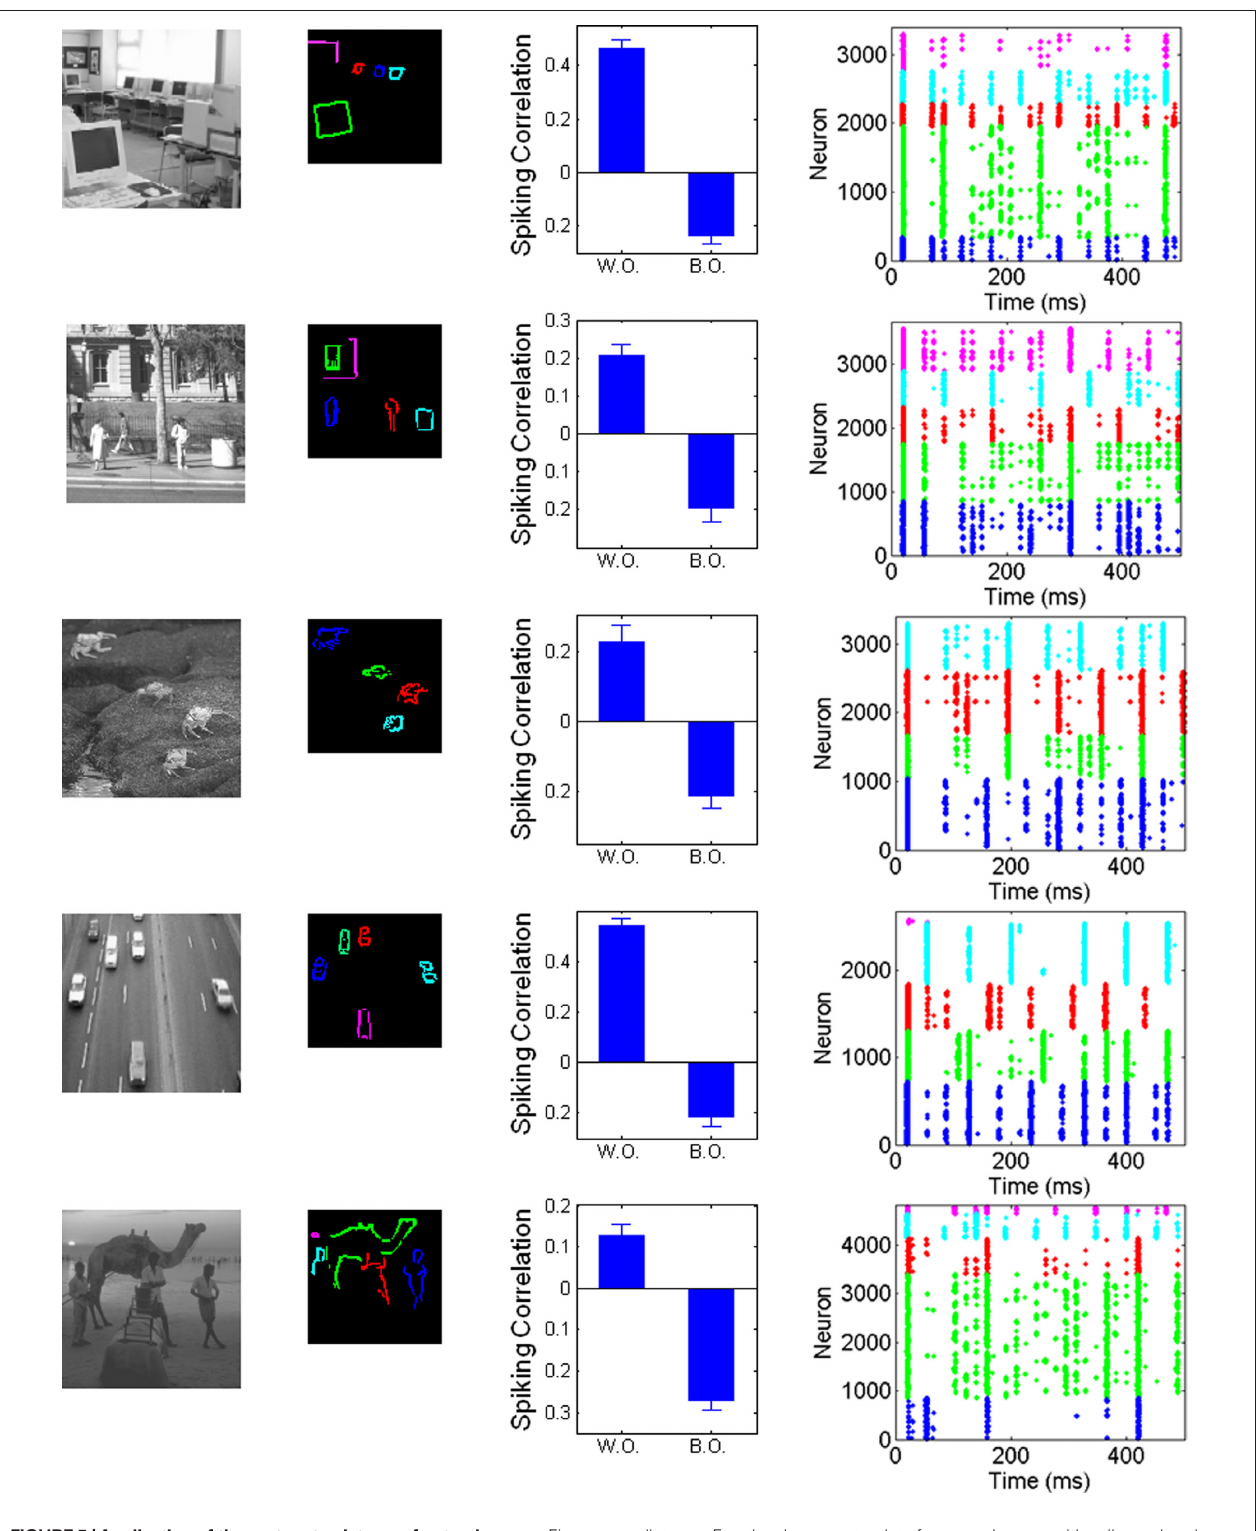
Figure 5 | Application of the system to pictures of natural scenes. First column: original pictures. Second column: neurons with activity over 50% of the maximum, assigned by hand to different objects within the scene. Third column: Correlation between PSTH within and between objects, controlling for